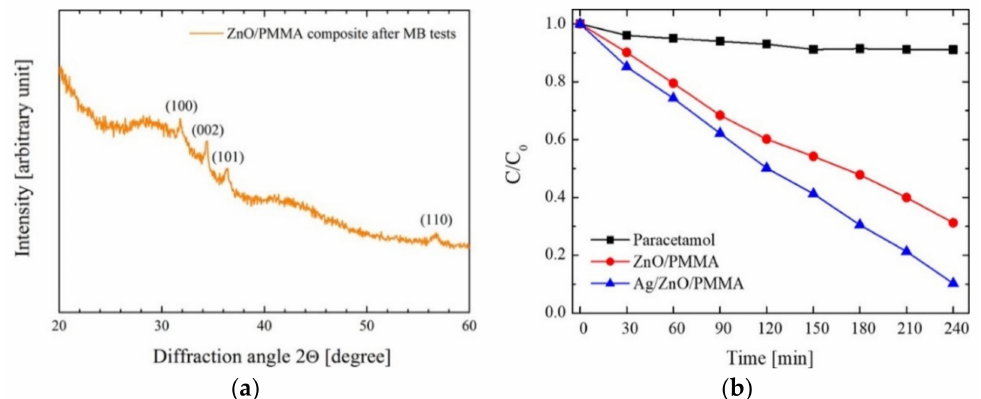
Figure 11. XRD pattern of ZnO/PMMA composite after the seven MB discoloration runs [62]. ( a ) Degradation of paraceta- mol drug as a function of irradiation time for paracetamol alone (squares), paracetamol with ZnO/PMMA (circles), and paracetamol with Ag/ZnO/PMMA (triangles) samples ( b ), under UV illumination [61] (both works by Alessandro Di Mauro are licensed under a Creative Commons Attribution (CC BY